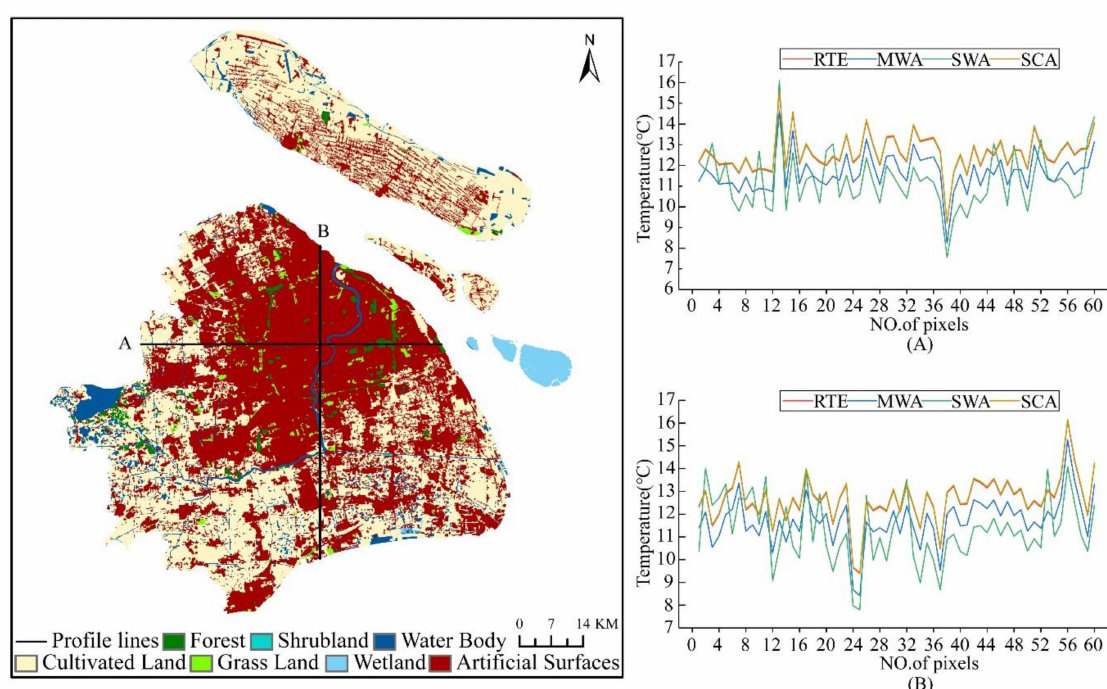
Figure 4. The land cover types in shanghai and the LST profile lines on 21 January 2020. ( A ) is the LST profile line in the east–west; ( B ) is the LST profile line in the